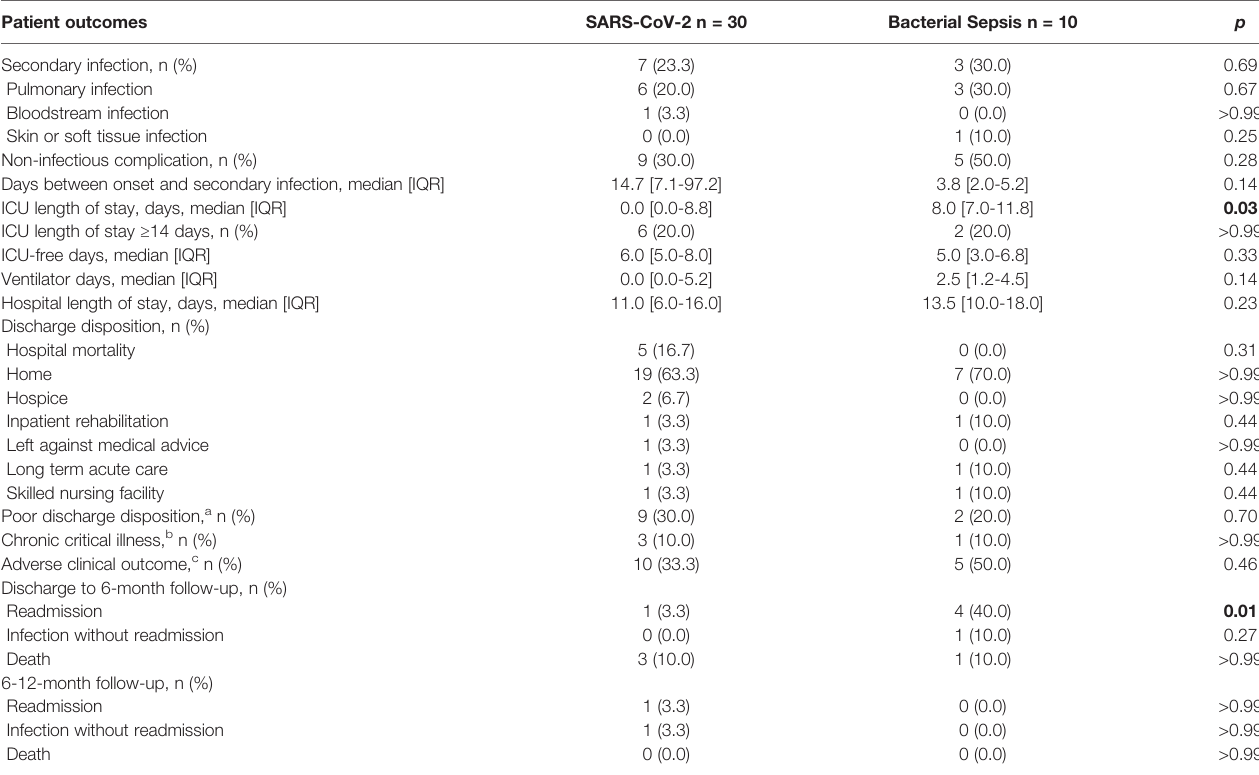
TABLE 2 | Clinical outcomes for patients with SARS-CoV-2 or bacterial sepsis. Patient